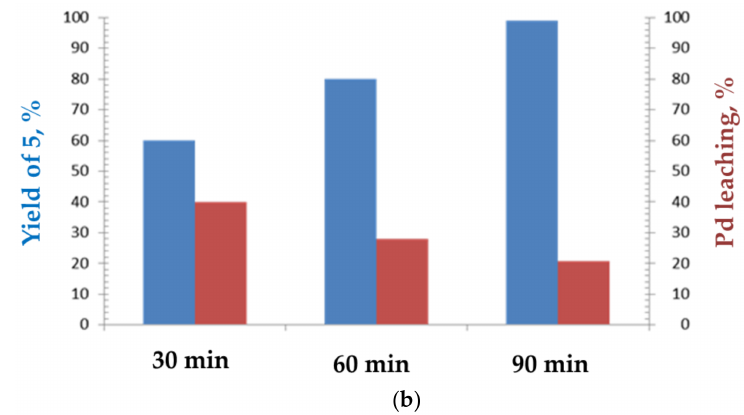
Figure 3. ( a ) Pd leaching (red, percent of the initial content), yield of 5 after 30 min (blue), yield of 5 in 24 h after separation from heterogeneous catalyst (green, “hot” filtration test); and ( b ) dependence of Pd-leaching upon yield of 5.